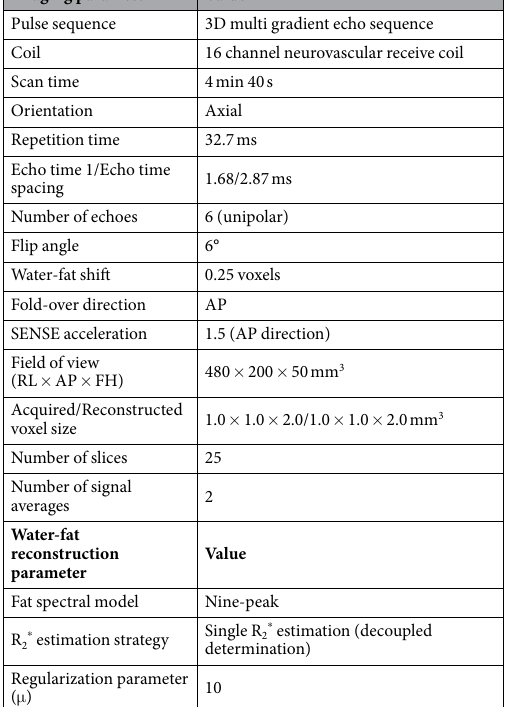
Table 1. Summary of imaging and reconstruction parameters for the water-fat data. Data were acquired under shallow breathing to reduce motion artefacts. The flip angle was chosen small to reduce T 1 -weighting. No contrast agents or pharmacological agents were administered. Data were reconstructed using a previously described method 12 . RL = right-left, AP = anterior-posterior, FH = feet-head direction. The regularization parameter, μ , reflects the influence of assumed magnetic field spatial smoothness, and hence the influence of noise, in fitting of the water-fat MRI signal model to the data 12